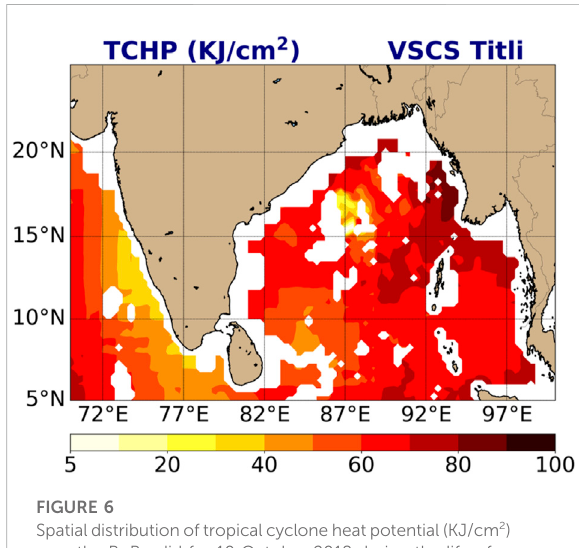
FIGURE 6 Spatialdistributionoftropicalcycloneheatpotential(KJ/cm 2 ) over the BoB valid for 10 October 2018 during the life of a very severe cyclonic storm Titli. The data was obtained from the National Remote Sensing Centre- Indian Space Research Organisation,